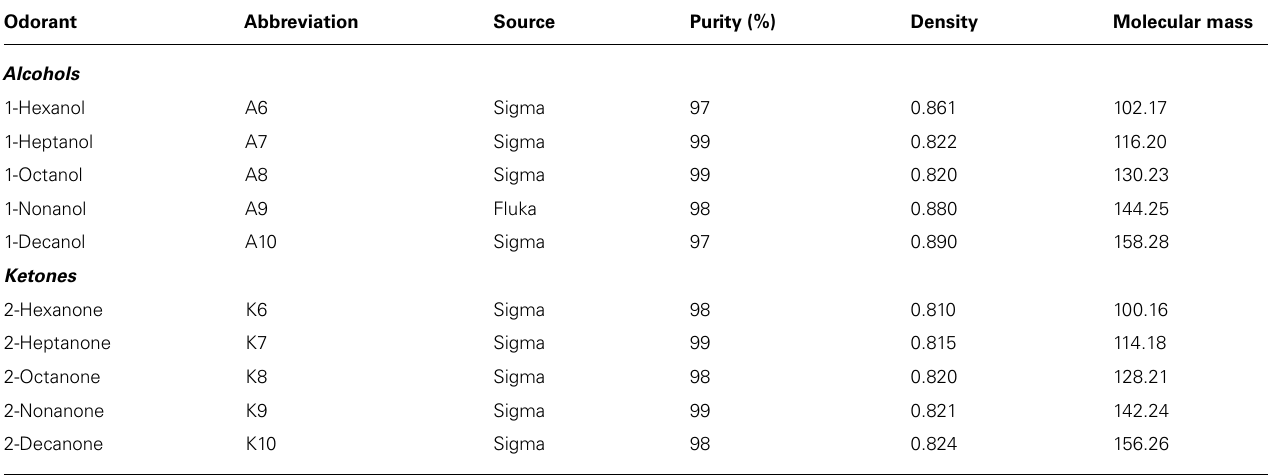
Table 1 | Panel of odorants used in